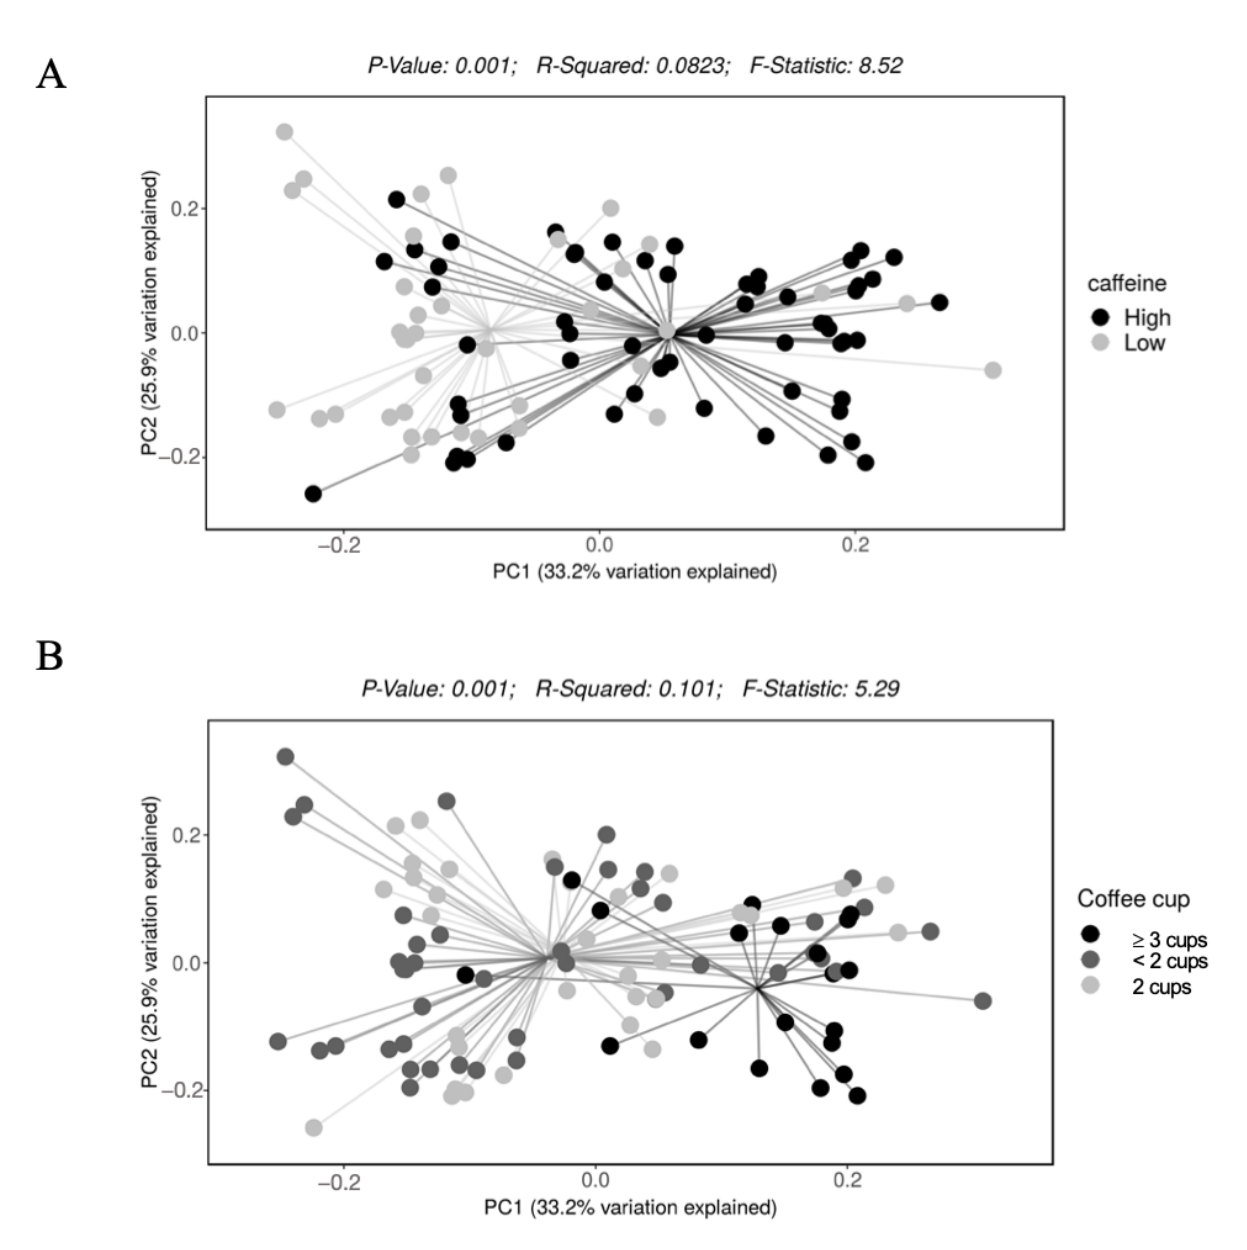
Figure 3. Beta diversity of gut microbiota based on daily intake of ( A ) caffeine and ( B ) coffee.